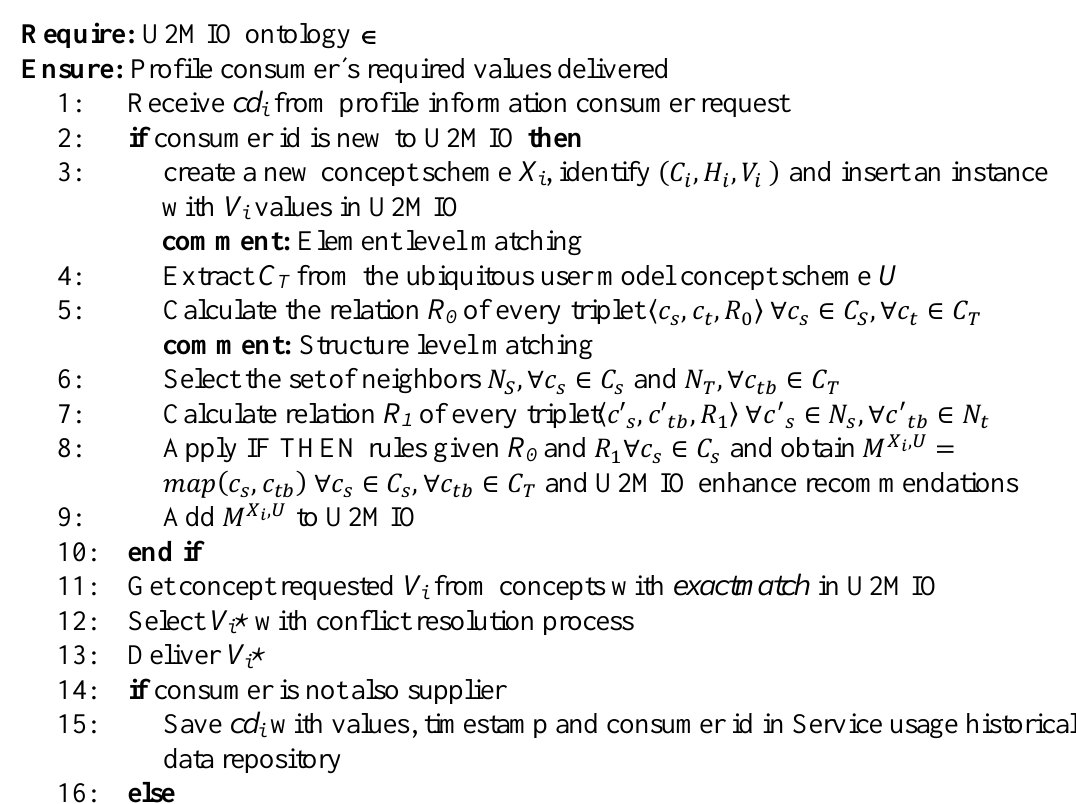
Algorithm 2. Consumption of profile information from the ubiquitous user